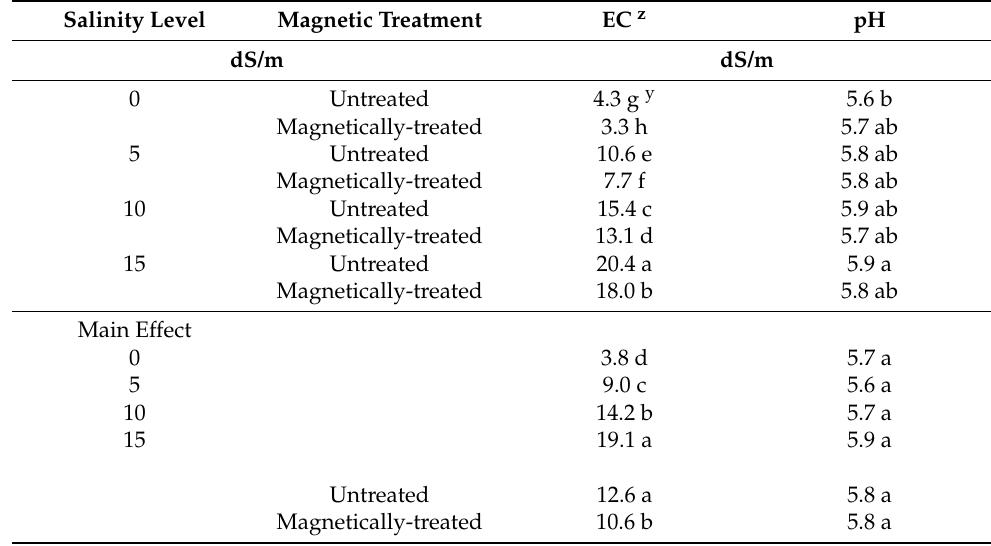
Table 4. The electrical conductivity and pH of the growing medium in the greenhouse experiment. Salinity